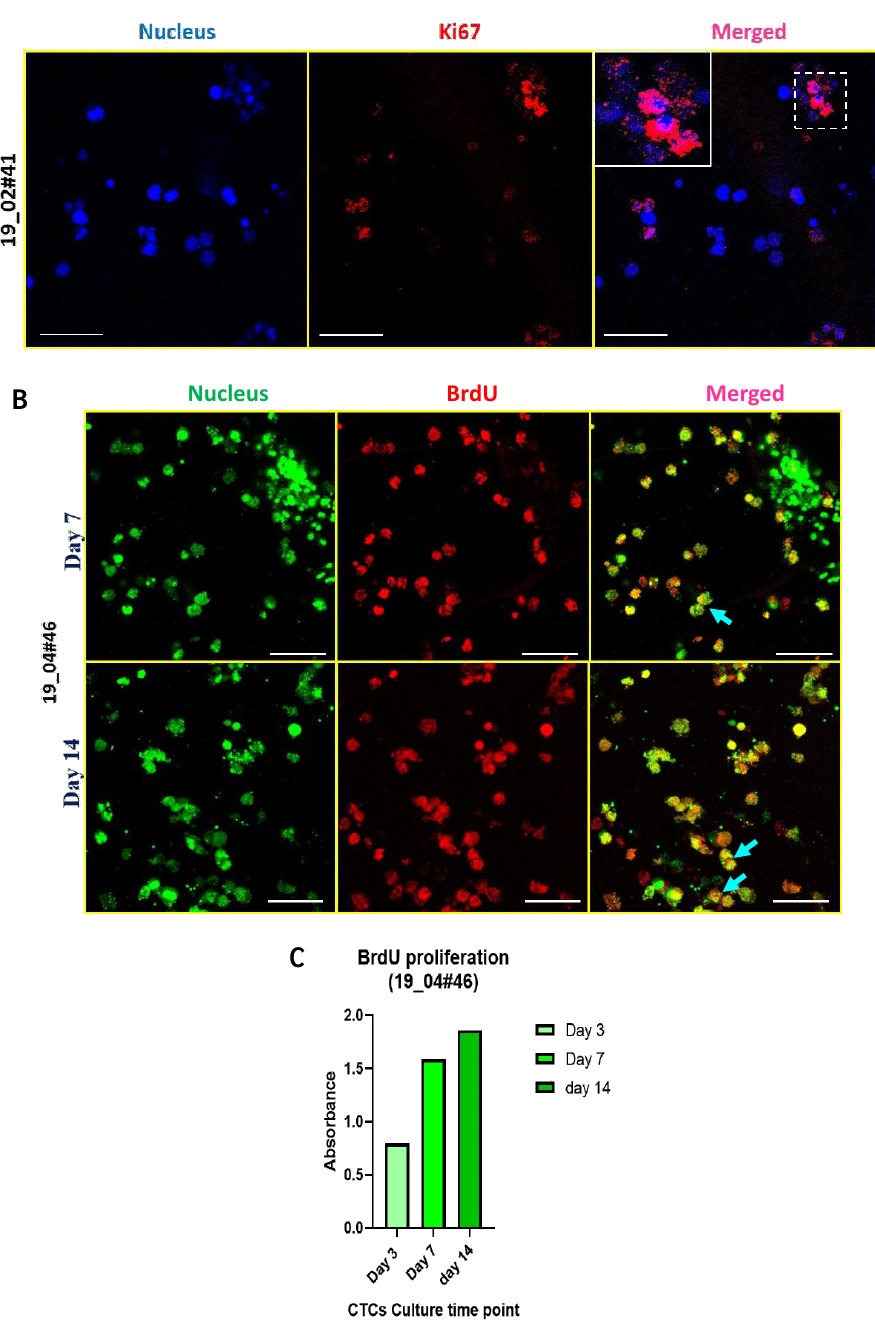
Figure 4. Active cell proliferation in breast cancer patient-derived cells cultured in 3D PCL sca ff olds. ( A ) Fluorescence images of Ki-67 positive patient blood cells harvested after 14 days of culture in